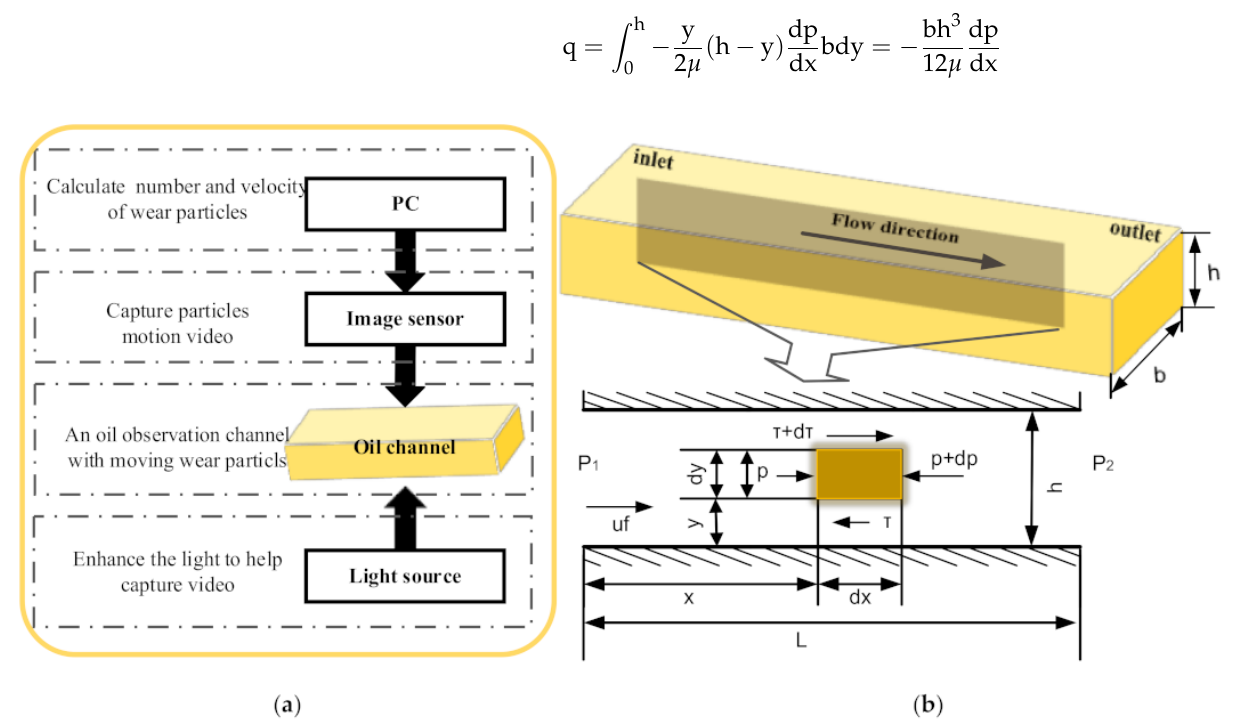
Figure 2. ( a ) Principle of the WKAS; ( b ) flow analysis of oil in the microfluidic